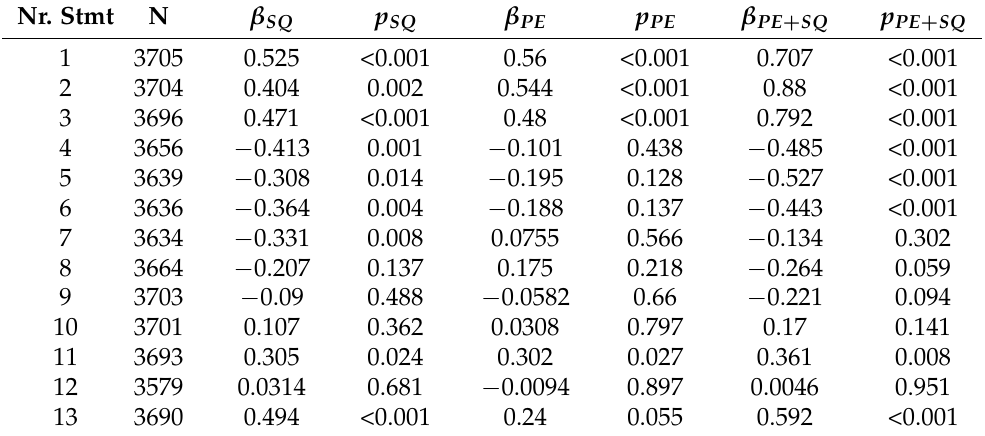
Table 3. OLS beta coefficients deriving from regressions with the statements as the dependent variable and a binary variable to measure the impact of being in the treatment groups with respect to the Control group. The regressions are ran controlling for demographics, vaccination status, frequency of travel and trust levels of the participants. Tables of the regressions output are included in supplementary materials (Tables